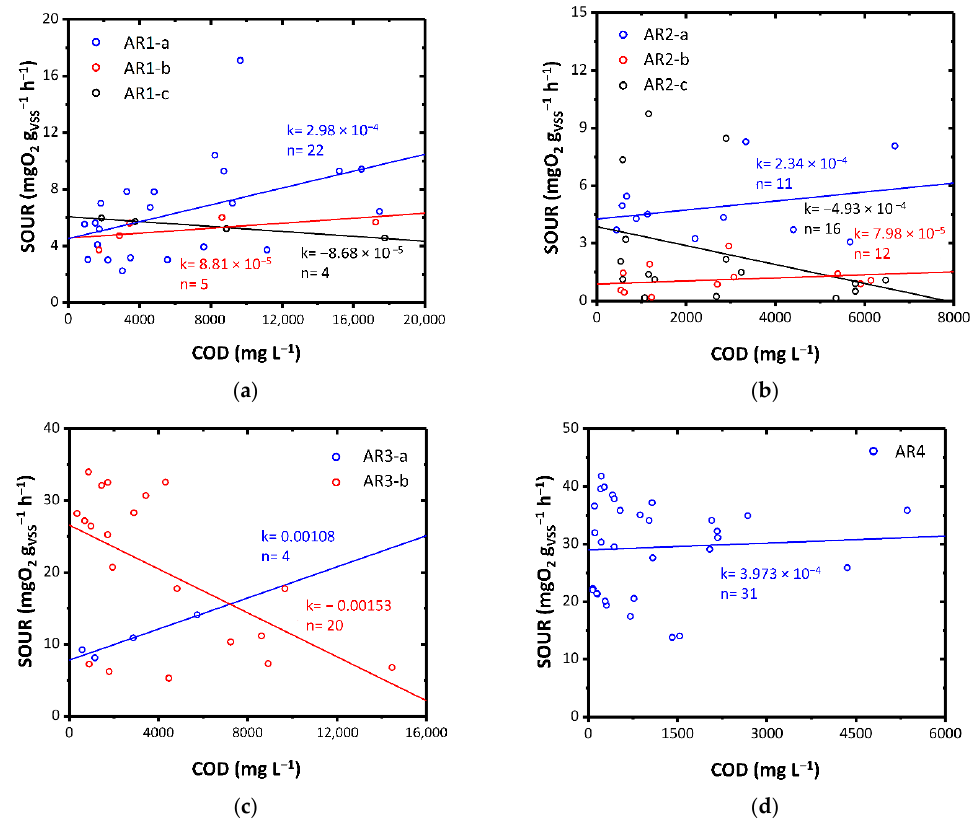
Figure 4. SOUR as a function of COD for: ( a ) AR1-a, AR1-b and AR1-c; ( b ) AR2-a, AR2-b and AR2-c; ( c ) AR3-a, and AR3- b; ( d ) AR4. Colors highlight diverse load rates. k: angular coefficient of the linear fitting expressed as mgO 2 L g VSS − 1 h − 1 mgCOD − 1 ; n: number of data points.